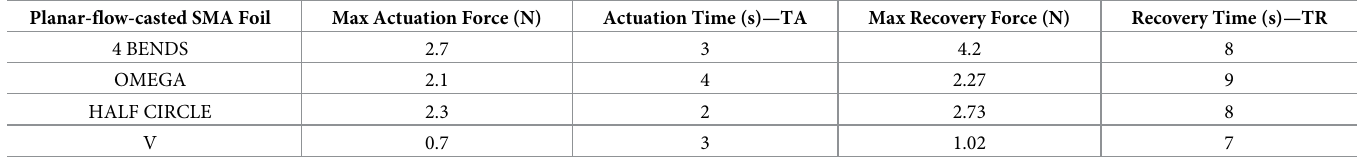
Table 3. The maximum forces measured during actuation (current on) and recovery (current off) and the times needed for the four different shaped SMA bodies. Planar-flow-casted SMA